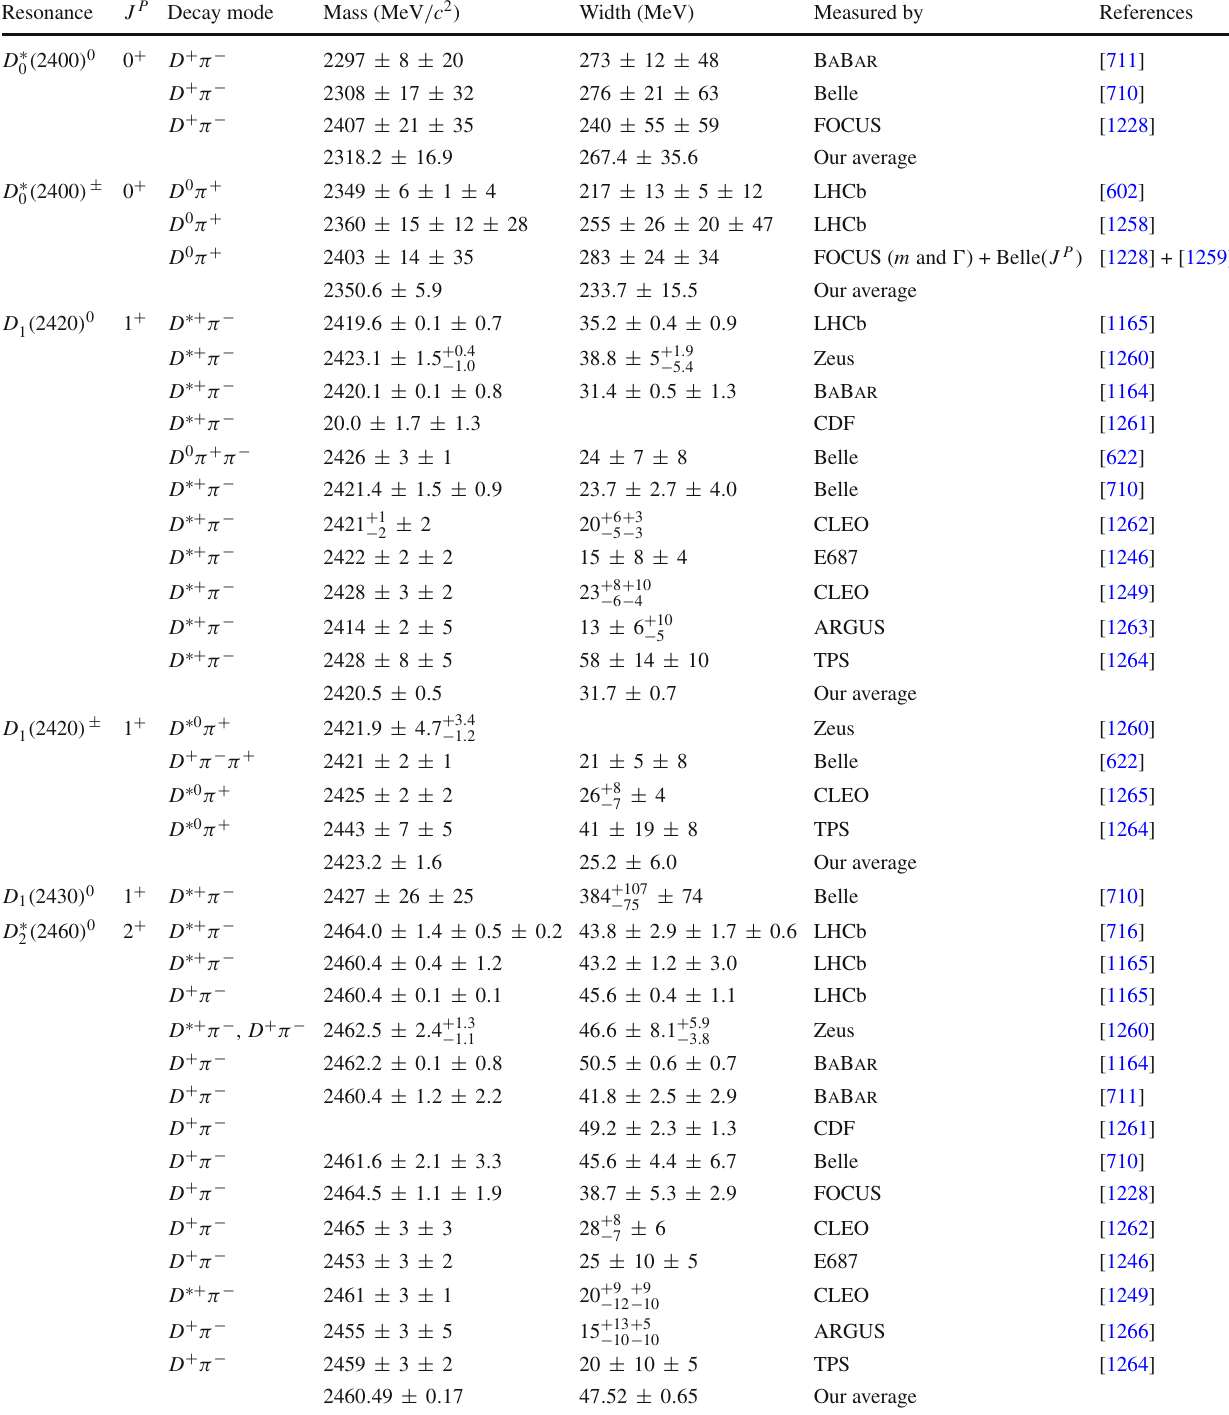
Table 290 Recent measurements of mass and width for different excited D mesons. The column J P list the most significant assignment of spin and parity. If possible an average mass or width is